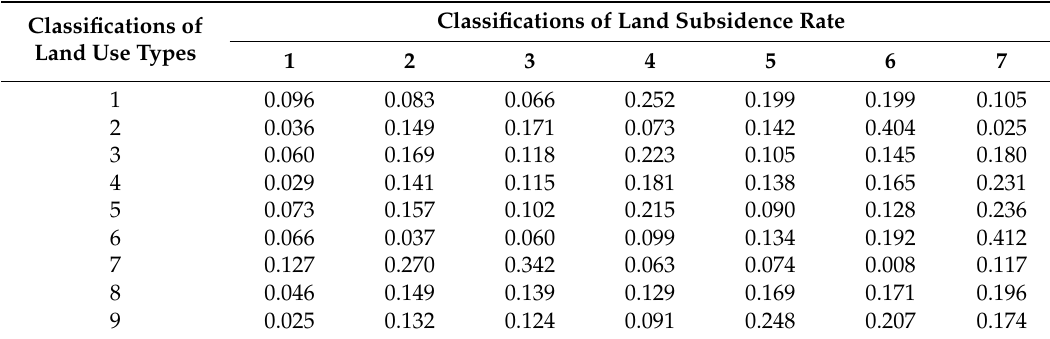
Table 4. The fractions of SDFP pixels of each deformation in each land use type. Classifications of